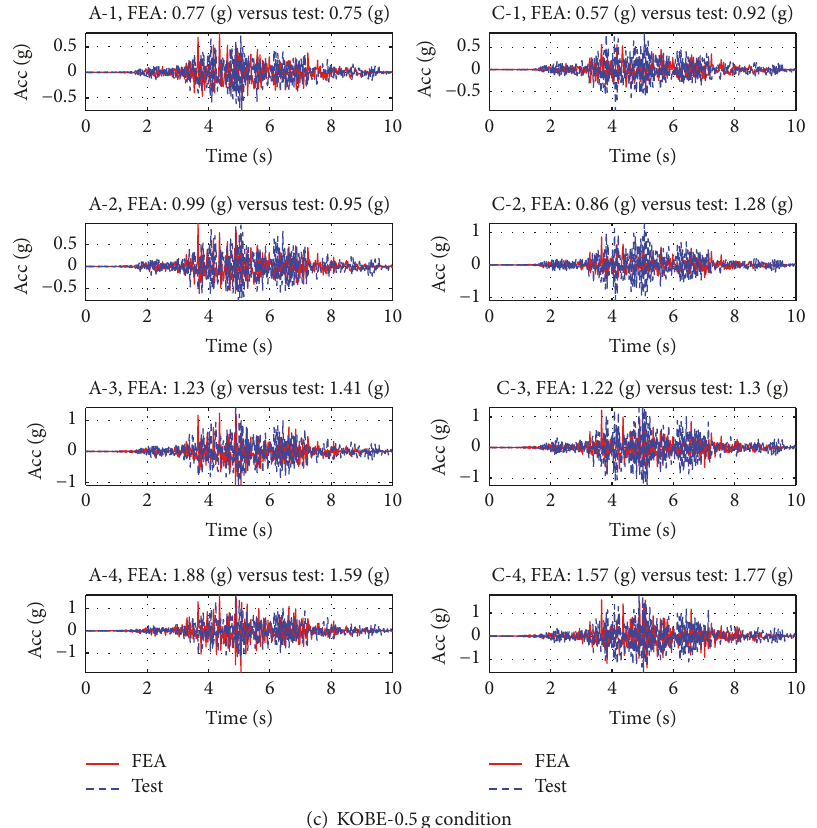
Figure 10: Acceleration time histories for different intensity earthquake events.